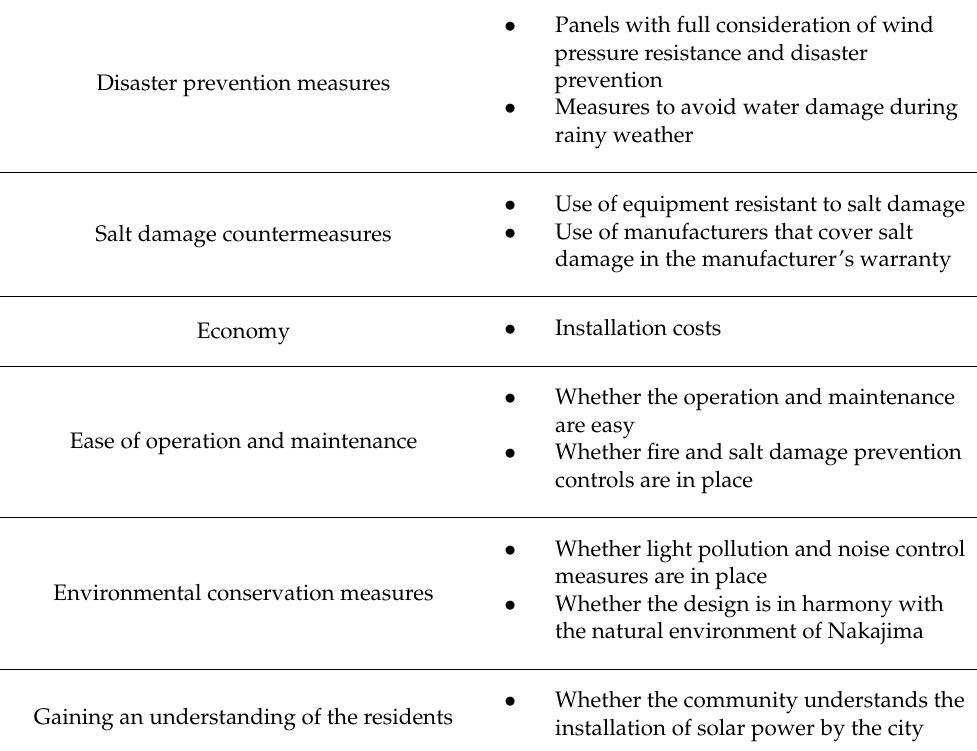
Table 1. Indices.